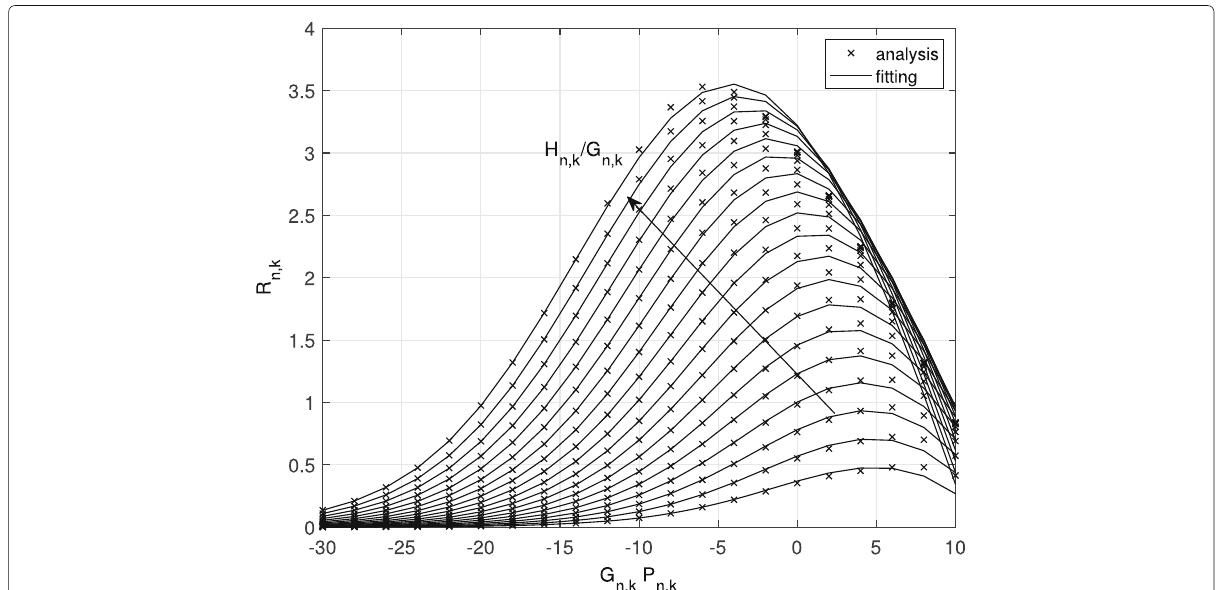
Fig. 4 R n , k ( P n , k ) as a function of G n , k P n , k for values of H n , k / G n , k between 2 and 20 dB with a step of 1 dB, and results obtained with the fitting function (25), considering a 16-QAM constellation